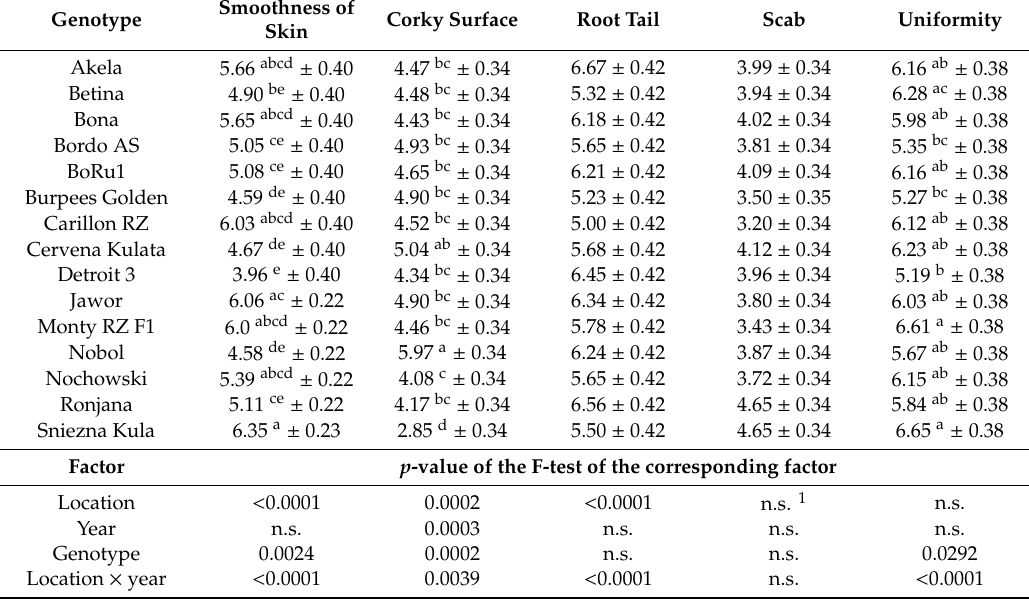
Table 4. Mean values and analysis of variance (ANOVA) of results of the evaluation of beet regarding the skin smoothness, corky surface, root tail, scab, and uniformity of 15 di ff erent genotypes of beetroot grown in three research stations within the trial year 2017 and 2018, using 1–9 scale. Results represent the mean values ± standard error. Means followed by at least one identical letter were not significantly di ff erent from each